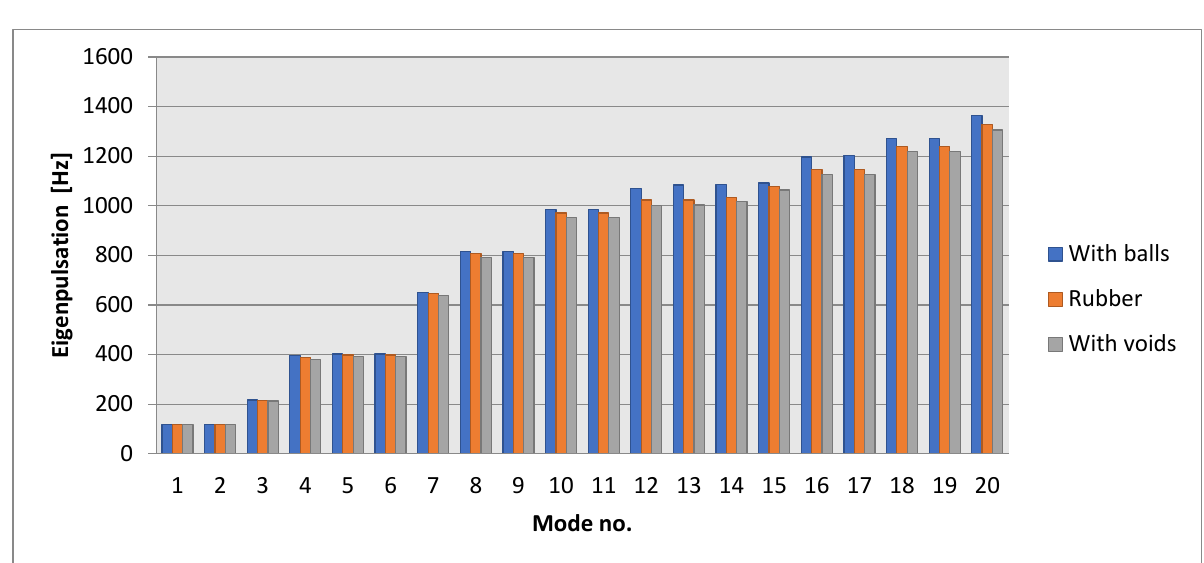
Figure 5. Eigenpulsations for three different cases.